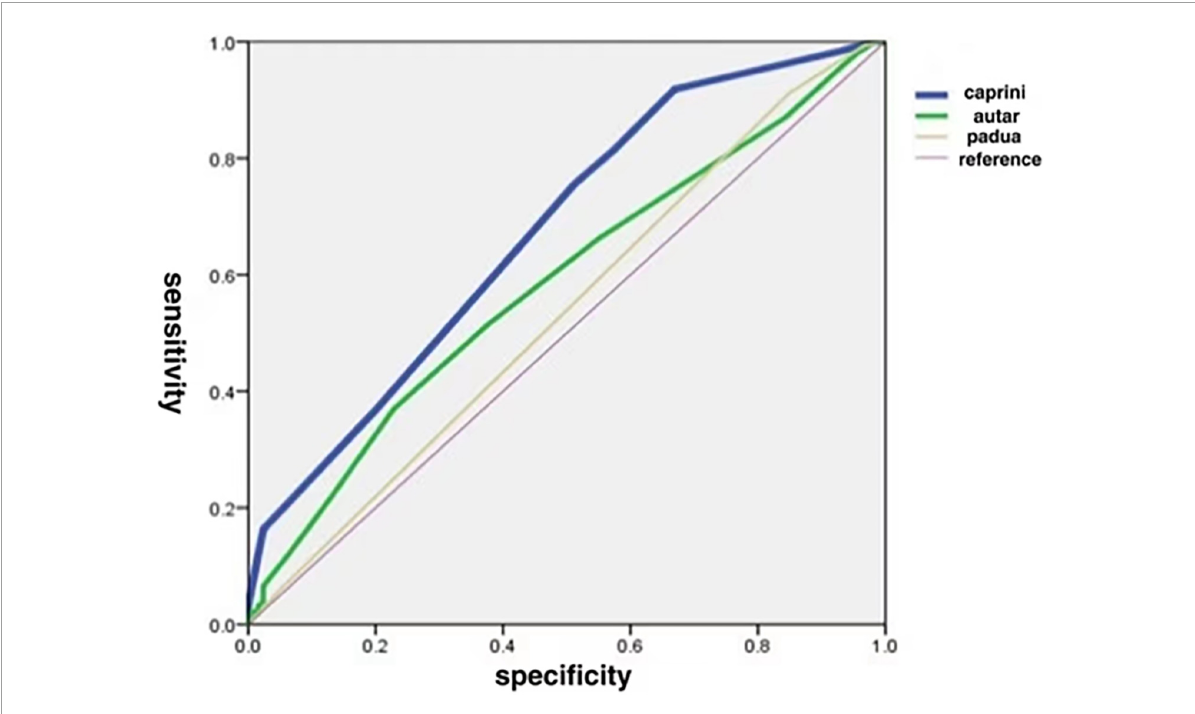
FIGURE1 Comparison of areas under ROC curve for the three thrombosis risk assessment models. ROC, receiver operating characteristics.